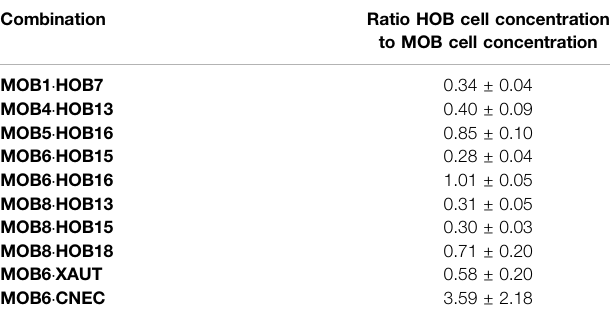
TABLE 5 | Ratio of HOB to MOB cell densities at the time of sampling. Values are reported as averages ± standard deviation ( n (cid:1) 3). XAUT,